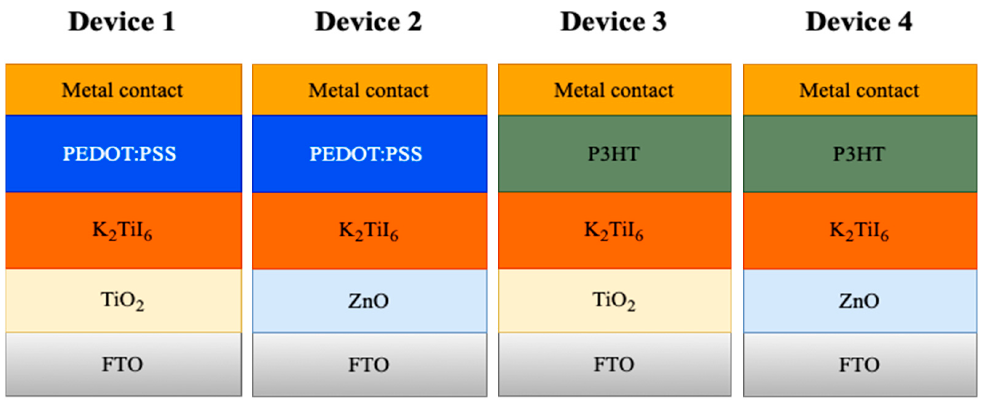
Figure 7. Schematic representation of solar cell devices.